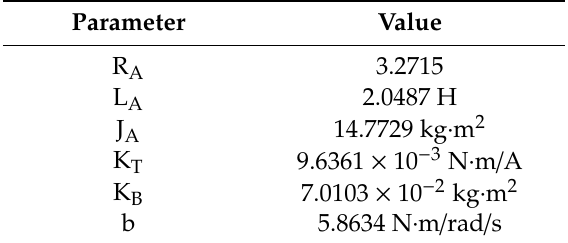
Table 1. Values of the DC motor’s